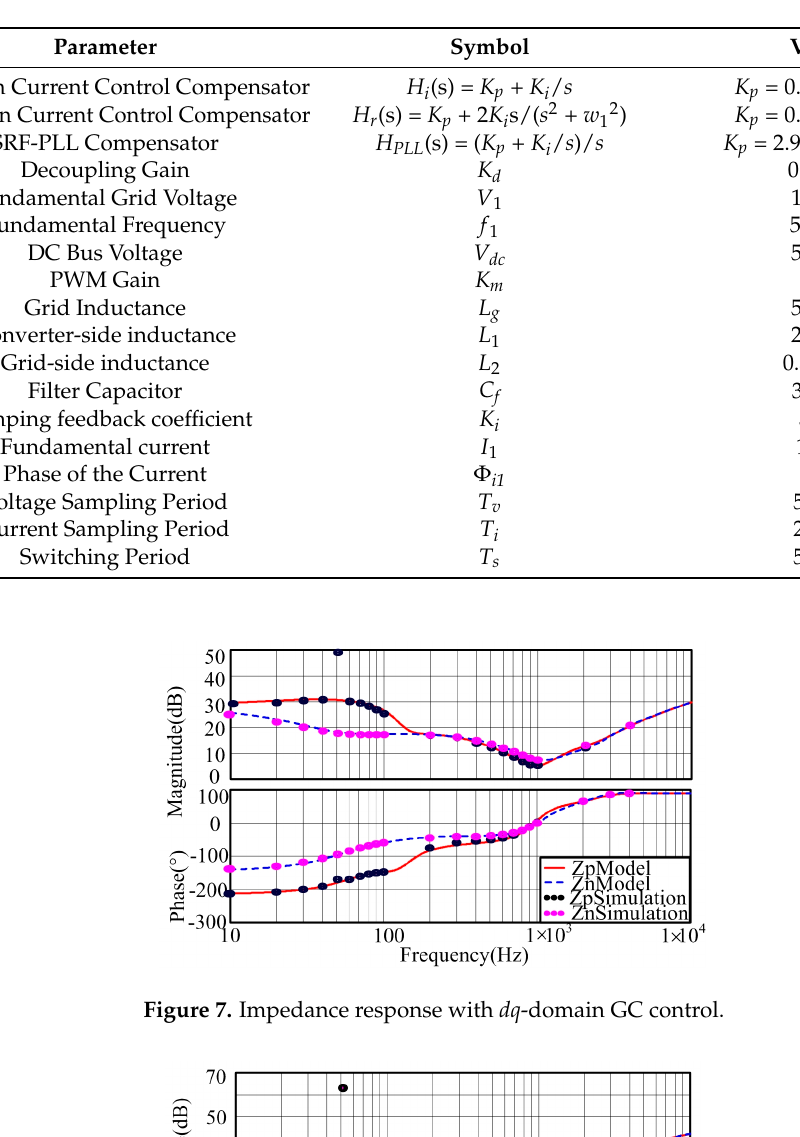
Table 1. Parameters of the simulation of grid-connected inverters.